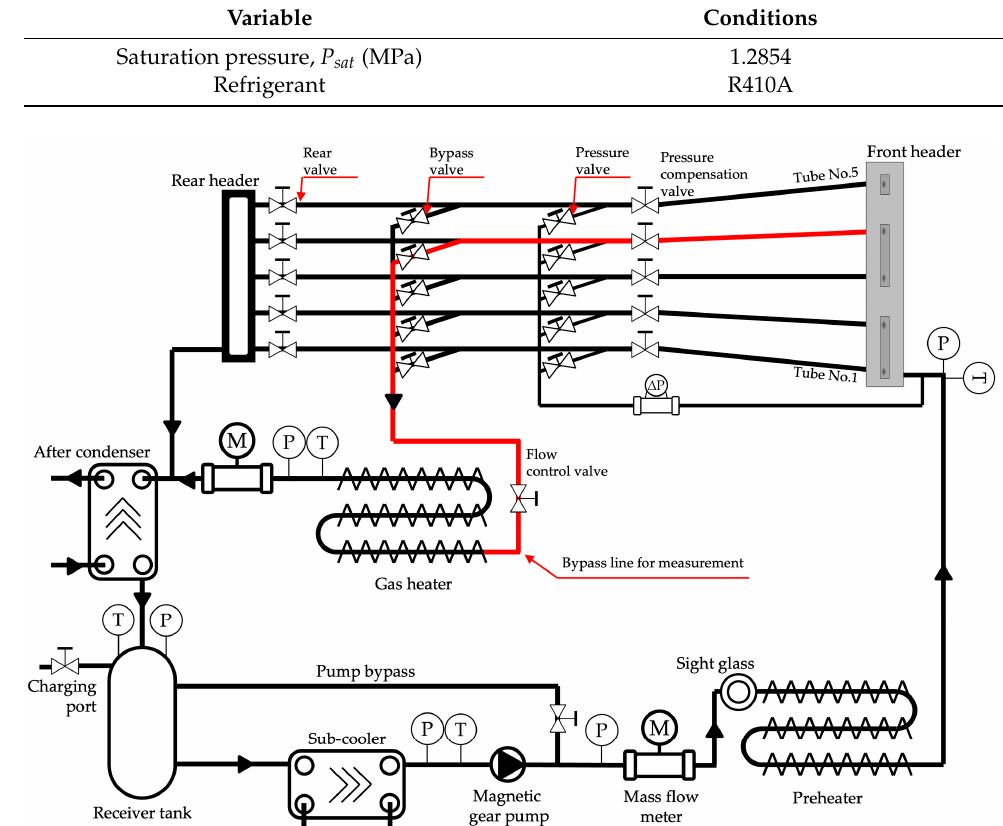
Table 1. Summary of experimental inlet conditions.